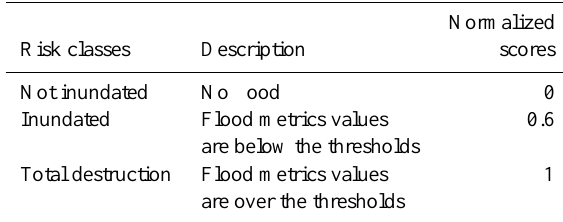
Table 4. Risk classes and normalized scores for